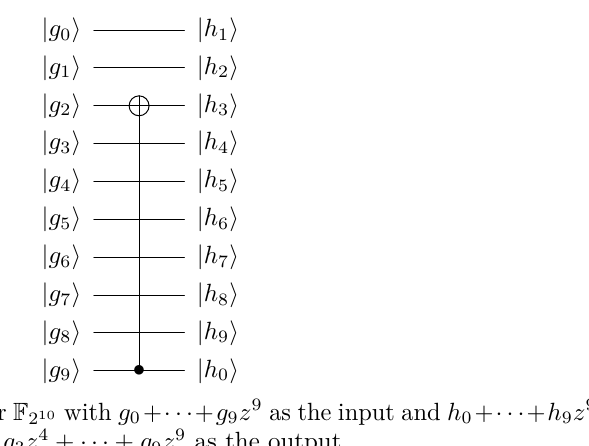
with g + · · · + g 9 as the input and h 0 9 z 2 10